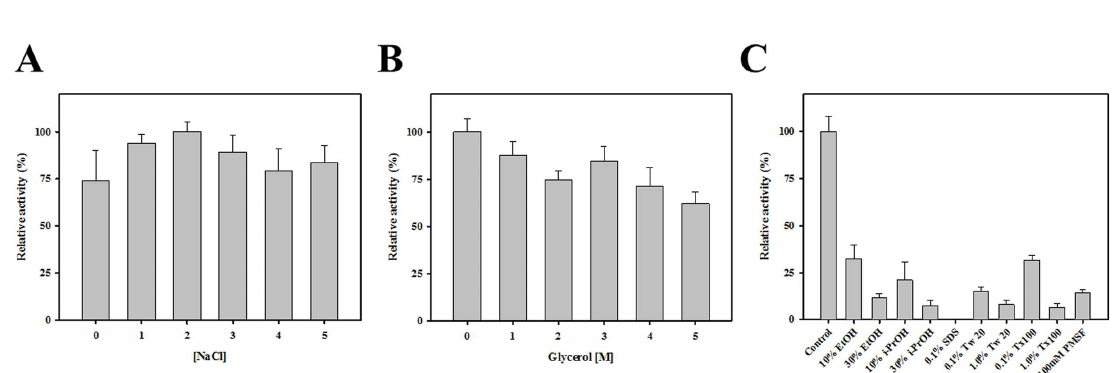
Fig 6. Effect of NaCl (A) and glycerol (B) on the activity of Ea EST . Relativeactivity was determined by incubating the enzyme with different concentrations of NaCl and glycerol(0 to 5 M). The maximum activity value obtainedwas set to 100%. (C) Chemical stability of Ea EST. Residualactivity after 1 h of incubation is expressedrelativeto the originalactivity obtainedwithout the addition of chemicalcompounds(100%).